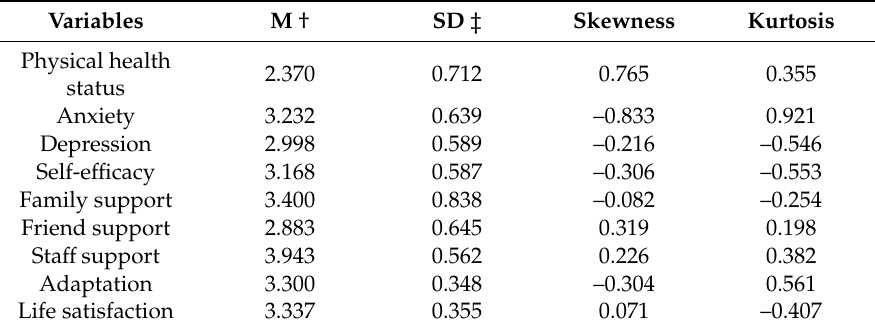
Table 3. Descriptive statistics of measured